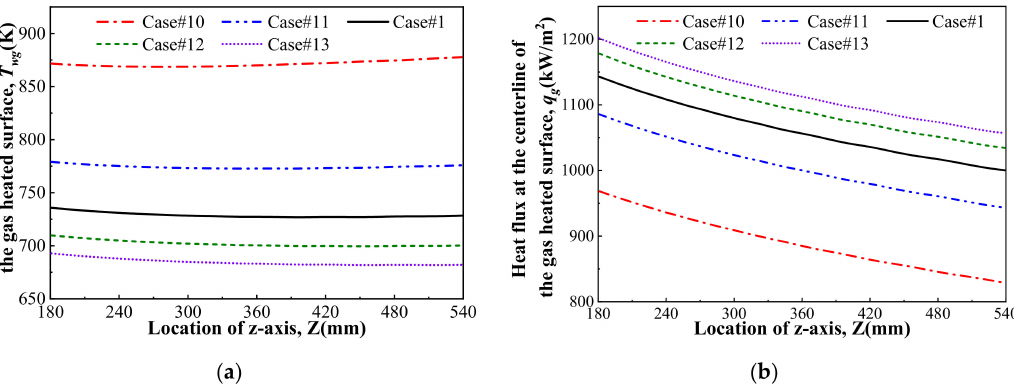
Figure 20. Variation of T wg and q g at the centerline of the gas side wall with mass flow rate of kerosene: ( a ) T wg ( b ) q g